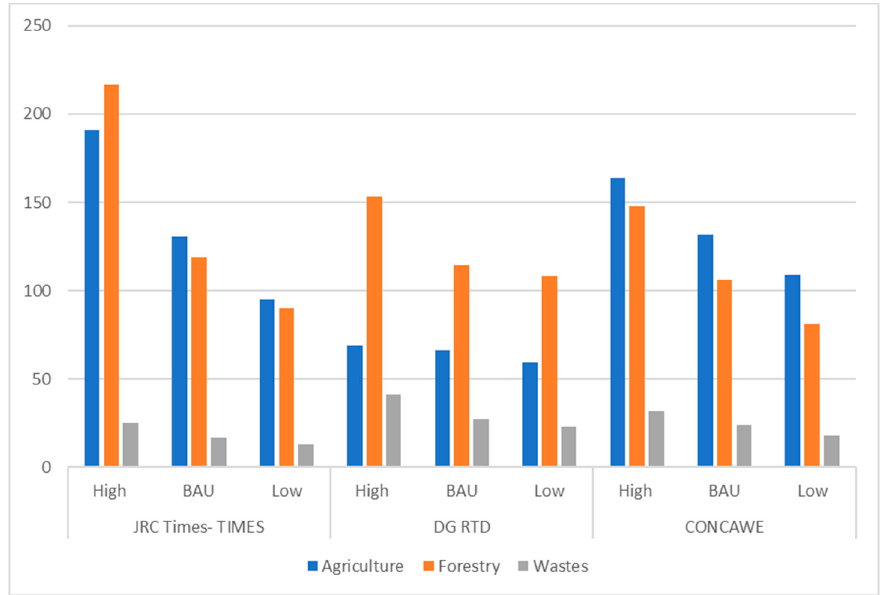
Figure 1. Feedstock potentials (Mtoe) from the three selected studies for 2030.